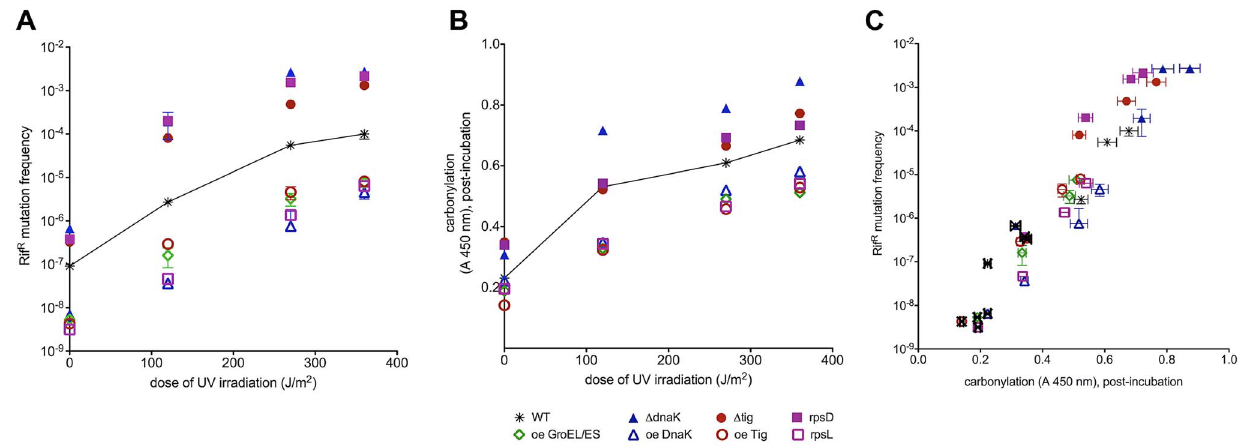
Figure 4. UV-induced mutation frequencies correlate with total proteome carbonylation. (a) Dose response of UVC induced mutation frequency in E.coli strains with increasing chaperone activity and translation accuracy. (b) Protein carbonylation at the end of the recovery period correlates with the UVC radiation dose. (c) Correlation between the UVC induced mutation frequency and protein carbonylation measured immediately after irradiation. Spontaneous mutation frequencies for each strain are labelled with an X. The results of mutation frequencies are given as median of 3 measurements, each in triplicate. Protein carbonylation measurements are presented as mean of 3 measurement, each in triplicate. Error bars represent the standard deviation. ‘‘Oe’’ stands for over-expression.